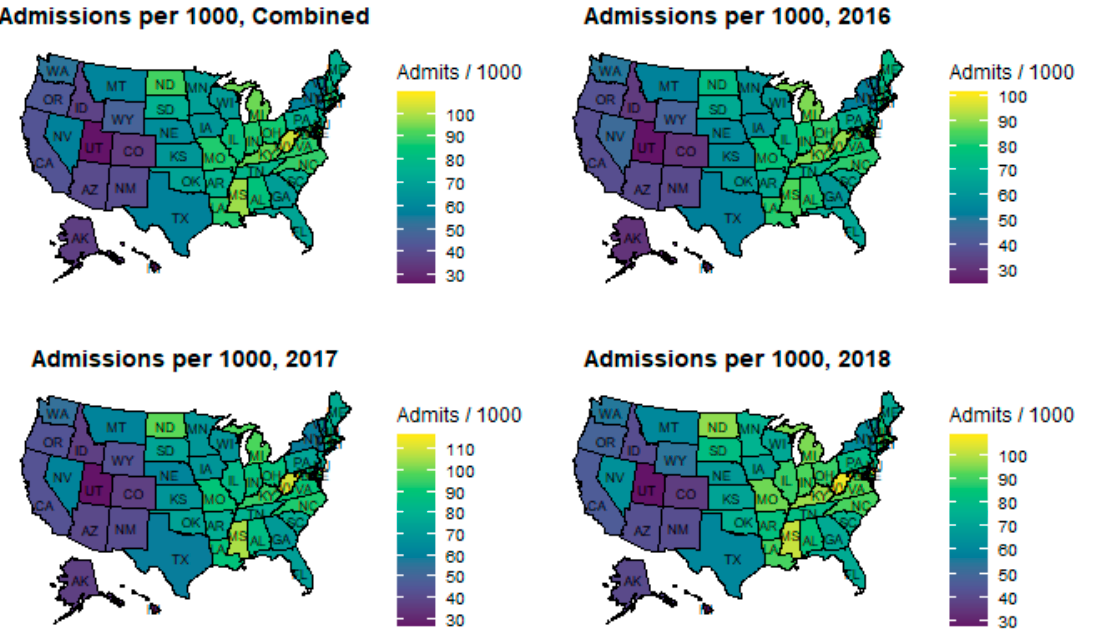
Figure 10. Admissions per 1000, 2016 through 2018.